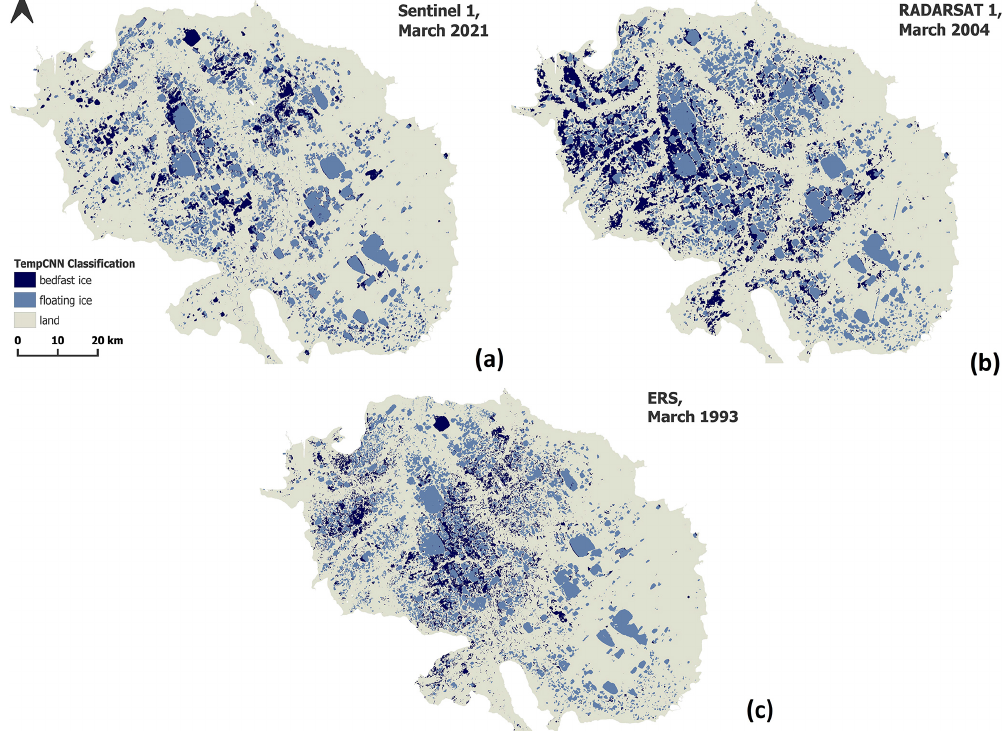
Figure 7. A sample of TempCNN classification output for the OCF, Yukon, Canada: (a) Sentinel-1, March 2021; (b) RADARSAT-1, March 2004; (c) ERS, March 1993. Dark blue, light blue, and grey represent bedfast ice, floating ice, and land, respectively. Table 2. TempCNN overall classification accuracy for 15 experiments designed to test the sensitivity of the network to removing certain years of data from the training set. Runs 1–5 correspond to the 20/80% split of the entire dataset; runs 6–10 were performed by training the network on 15 years of data and testing it on 3 years each from a different sensor; runs 10–15 were carried out by training the network on 17 years of data and testing it on 1 year of data that was originally reserved and was not part of the cross-validation procedure for determining the best architecture. The mean accuracy for each set of five runs as well as the mean of the three means can be found in the last two rows. Test